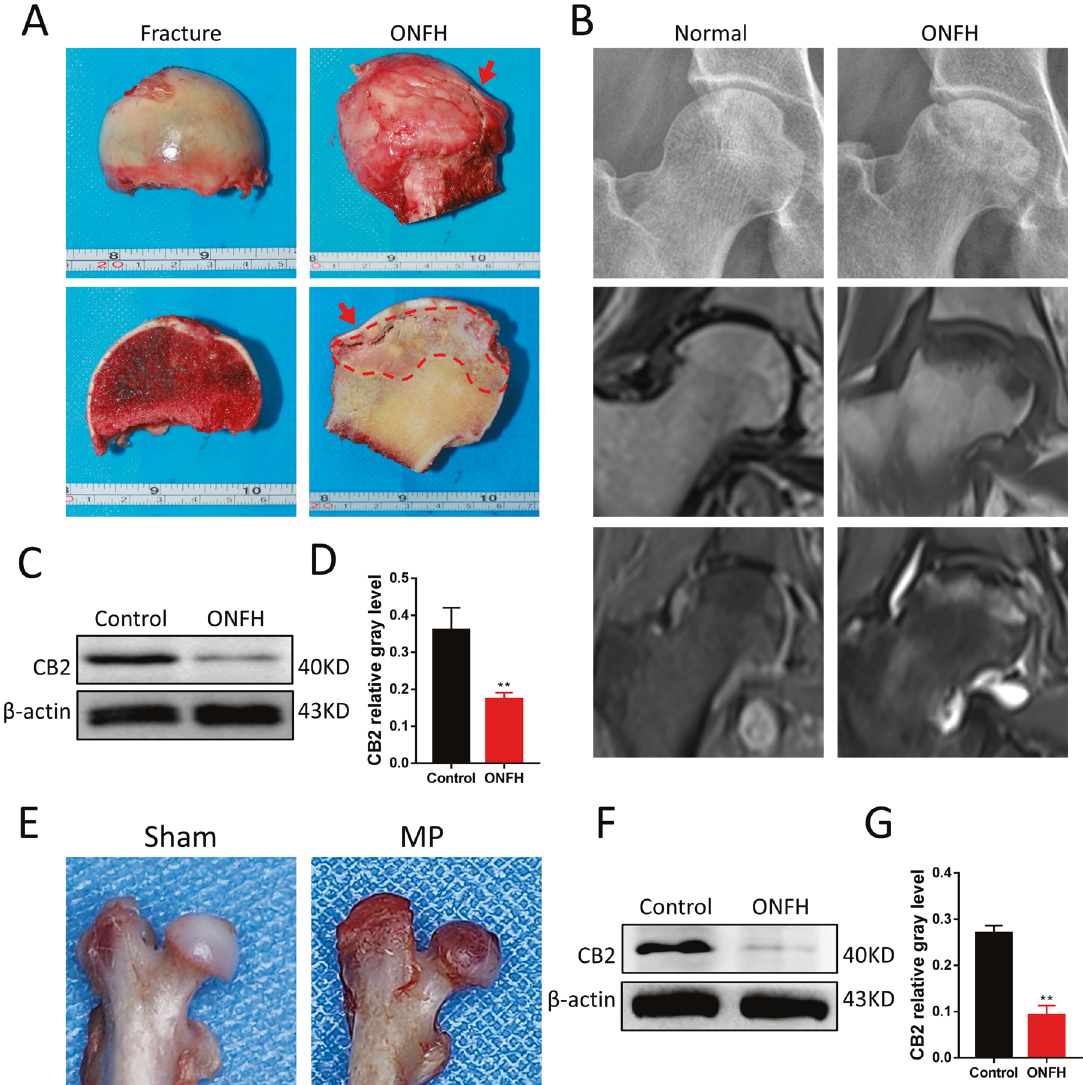
Fig. 1 Gross morphology and CB2 expression changes of GC-induced ONFH. A Gross morphology of non-ONFH and GC-induced ONFH femoral head. B X-ray and MRI images of hip joints. C , D Expression of CB2 in human femur tissues, n = 3 per group. E Representative photography of normal and pathological rat femoral heads. F , G Expression of CB2 in rat femoral head, n = 3 per group ( n = 3 per group, data are shown as mean ± SD, ** p <